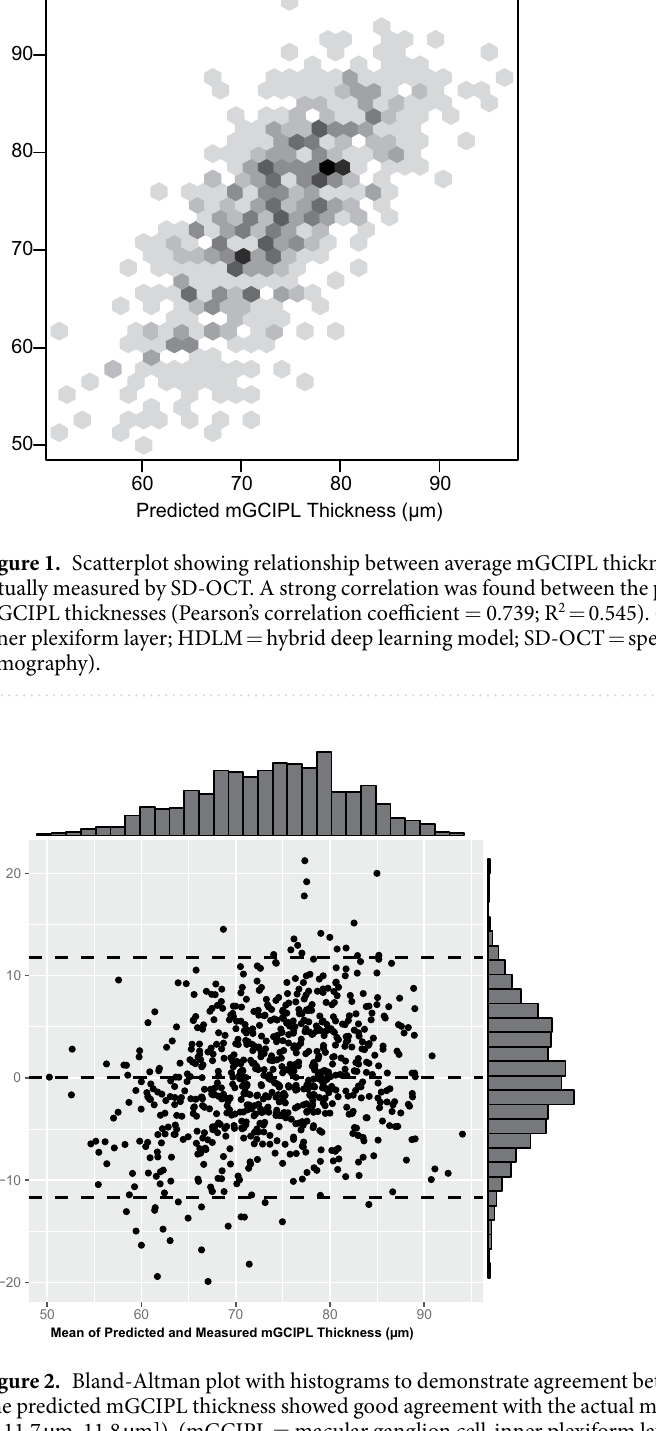
To estimate the possibility of learning random thickness rather than true features related to mGCIPL, the effi- cacy of the model was further investigated with various corruption ratios. As shown in Supplementary Table S1, the R 2 score and MAE of 5-fold CV became worse as the corruption ratio increased. With the corruption ratio ≥ 0.4, the R 2 scores were even negative values. When the prediction error of the model is worse than just predicting the mean value, the R 2 score can be negative 18 . Supplementary Fig. S1 depicts the relationship between the pre- dicted mGCIPL thickness and the target thickness with the corruption ratios of 0.4 (Fig. S1A) and 0.8 (Fig. S1B). With the corruption ratio of 0.4, a weak positive correlation could still be observed, whereas no correlation was found with the corruption ratio of 0.8.